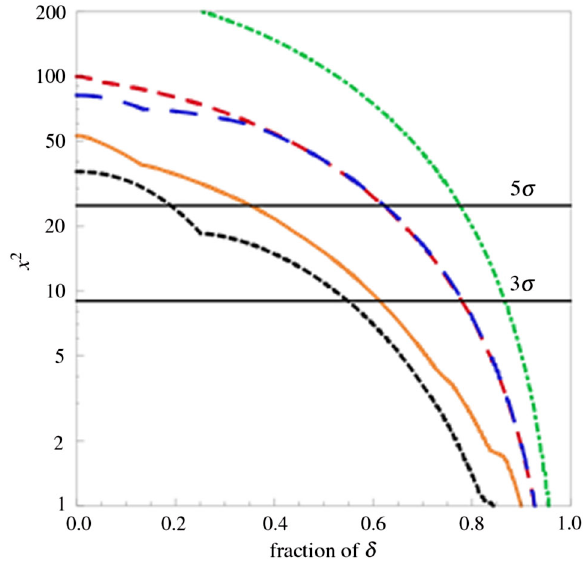
FIG. 26. The range of (cid:4) for which a 3 and 5 (cid:9) measurement of CP violation can be made by the same facilities as in Fig. 25.